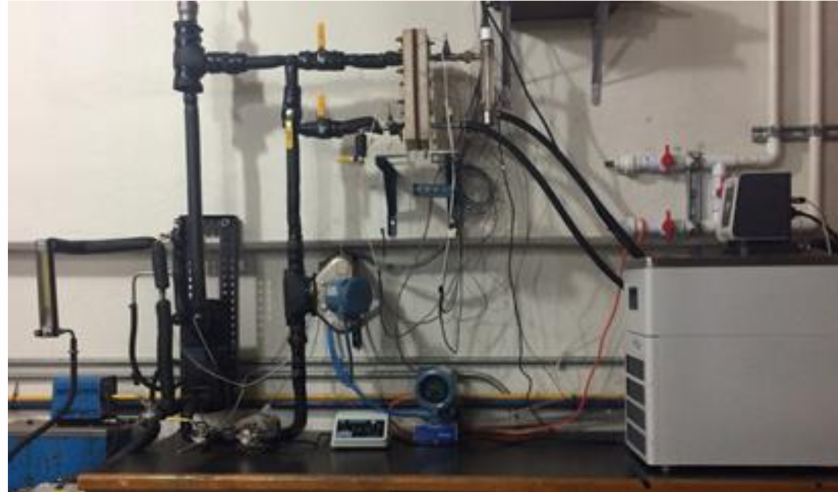
Figure 4. Photograph of the experimental